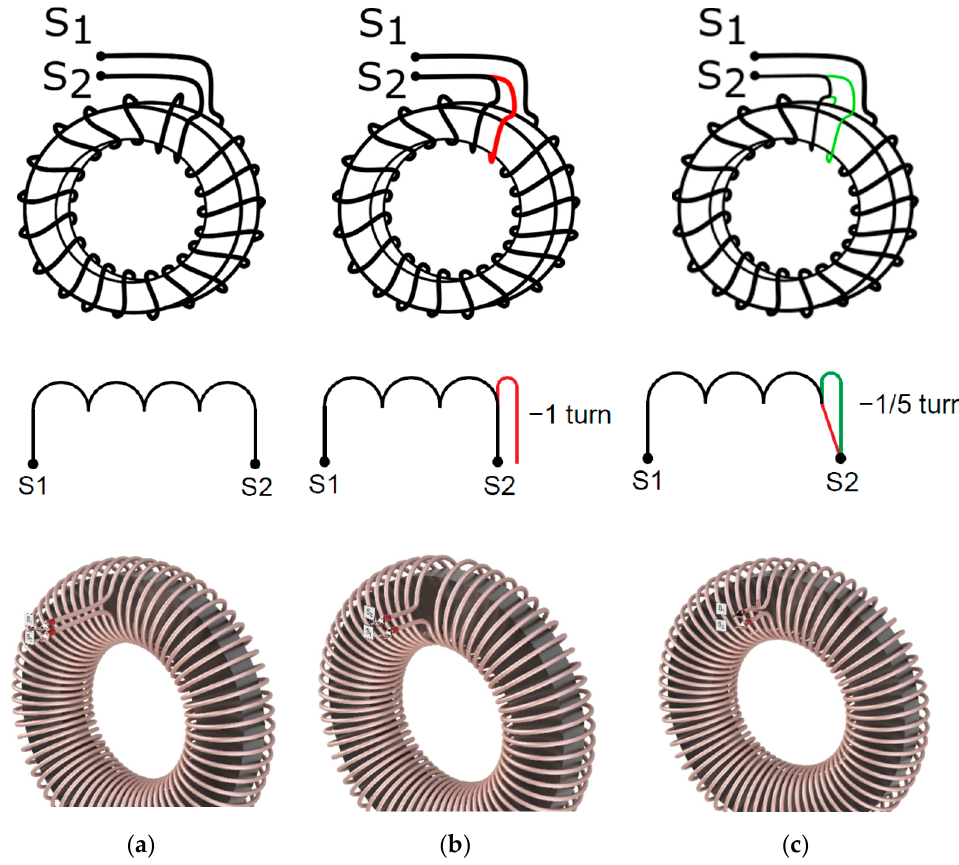
Figure 1. The secondary winding of the window-type CT without correction ( a ), with single turn correction ( b ) and with fractional correction of turns ( c ).